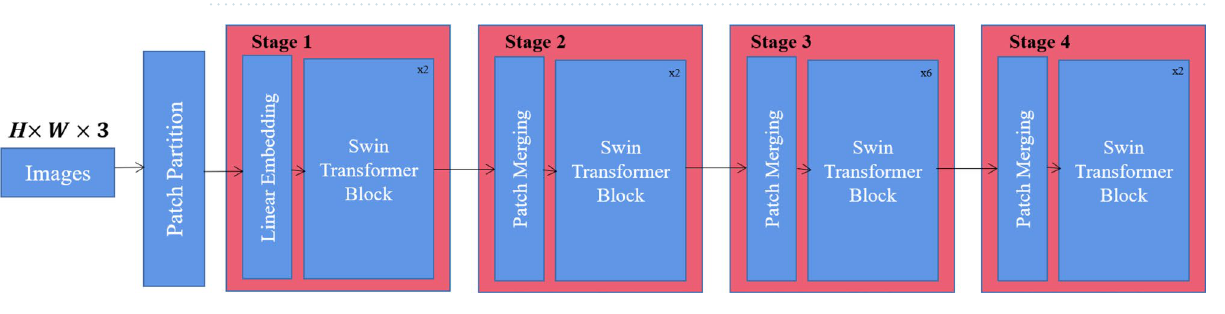
Figure 5. Our proposed framework for detecting very small defects on high-resolution cylinder liner images. Best viewed in color.